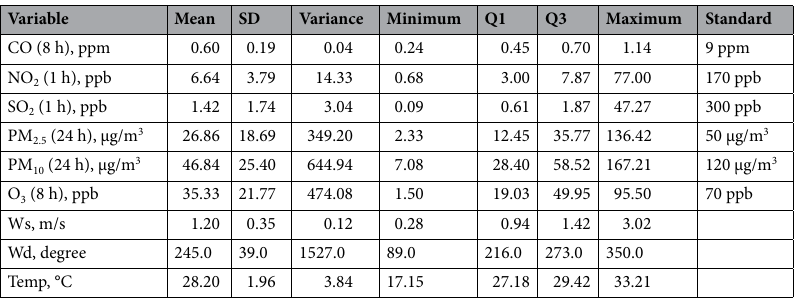
Table 1. The annual parameters of air quality in Ratchaburi province with Thailand standard Air Quality Index. Source: Pollution Control Department,